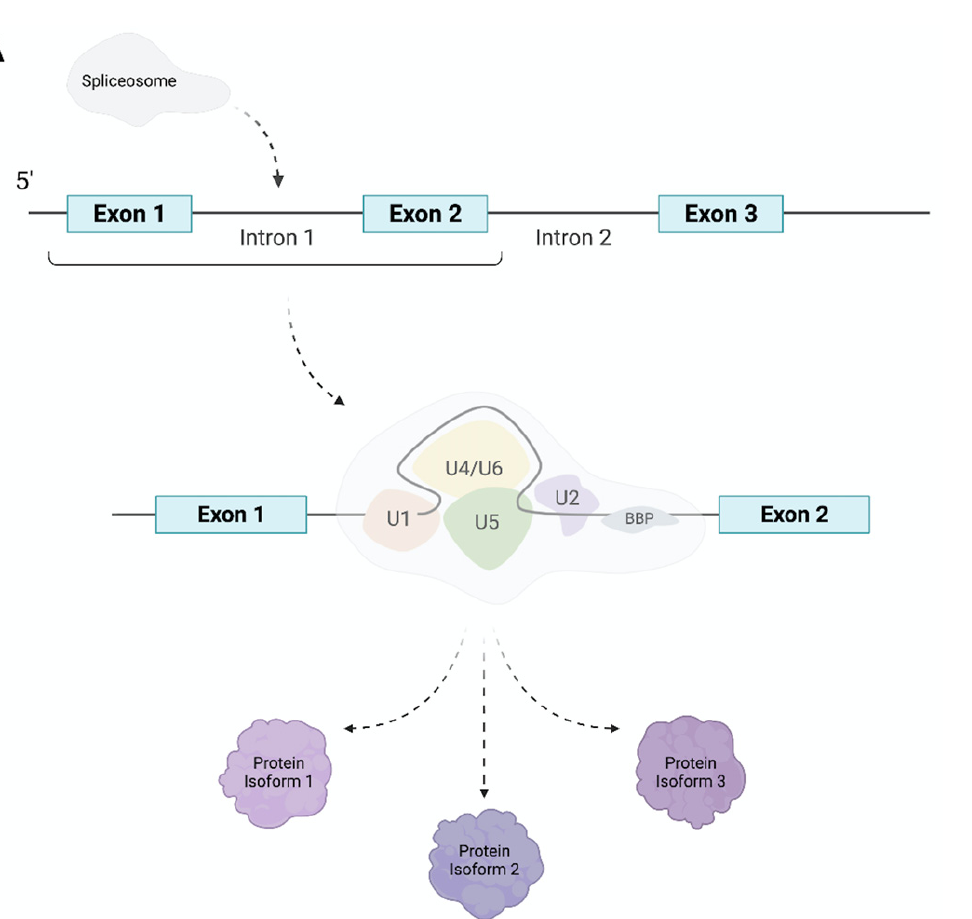
Figure 2. A schematic diagram simplifying the process of alternative splicing as well as depicting potential therapeutic strategies to mitigate mis-splicing. Briefly, the spliceosome, consisting of five crucial small nuclear ribonucleoproteins, as displayed in the figure, alongside other proteins cata- lyzes the splicing of pre-mRNA. Through coordinating the use of splice sites, the retention or exclu- sion of exons and any intron inclusion, alternative splicing results in the synthesis of multiple pro- tein isoforms from one gene transcript ( A ). Aberrant alternative splicing has been shown to have a critical role in the pathogeneiss of numerous diseases, consequently the design and development of therapeutics able to mitigate mis-splicing has emerged as a popular area of research. Two emerged promising strategies that recently emerged revolve around the elucidation of compounds with the ability to obstruct the splicesome. These include searching for drugs with the ability to inhibit spliceosome assembly or the interference of spliceosome function, as can be seen in ( B,C ). Moreover, the use of oligonucelotides as therapeutics, including spliceosome-mediated RNA trans-splicing